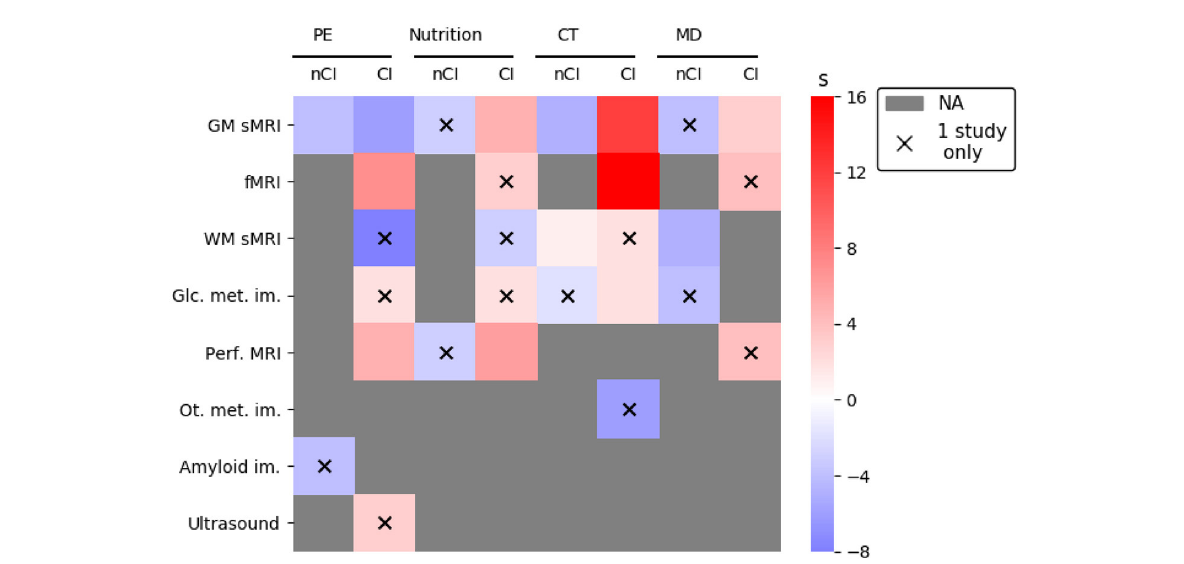
FIGURE4 Synthetic representation of the effects of interventions on neuroimaging biomarkers. The effect, or lack of effect, of an intervention was evaluated through a composite “s” score integrating the number of results/studies, the quality of the studies, and the presence of a sham intervention to compare to (see Section 2.3). Scores with a red tint indicate an effect of the intervention, while scores with a blue tint indicate a lack of effect of intervention. Were not taken into account to generate this figure results from intervention intermediate timepoints